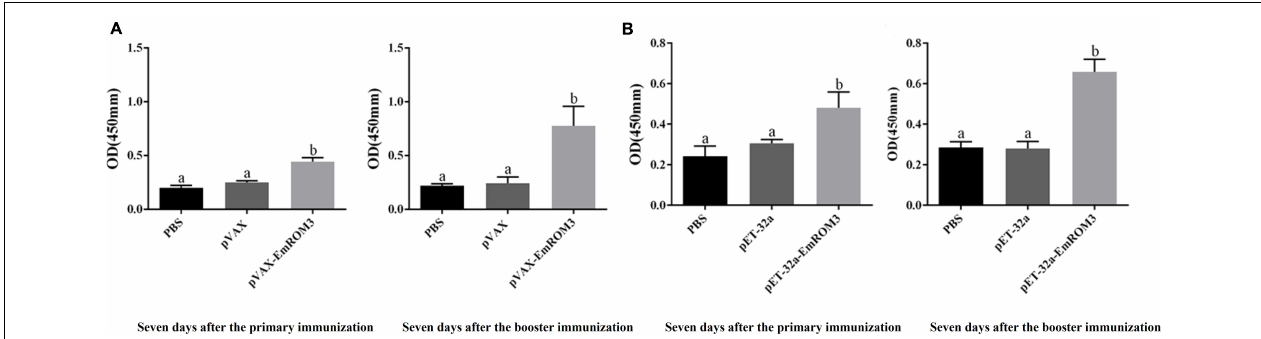
FIGURE 3 | Specific IgG titers activated by recombinant protein pET-32a EmROM3 and recombinant plasmid pVAX1-EmROM3 in chickens. N = 20, the error bars = standard deviation. (A) Serum IgG titers induced by recombinant plasmid pVAX1-EmROM3. Left, induced serum IgG titers 7 days after the first immunization; Right, induced serum IgG titers 7 days after the booster immunization. (B) Serum IgG titers induced by recombinant protein pET-32a EmROM3. Left, induced serum IgG titers 7 days after the first immunization; Right, induced serum IgG titers 7 days after the booster immunization. Significant difference ( P < 0 . 05) between groups is marked with different letters. No significant difference ( P > 0 . 05) between groups is marked with the same letter.